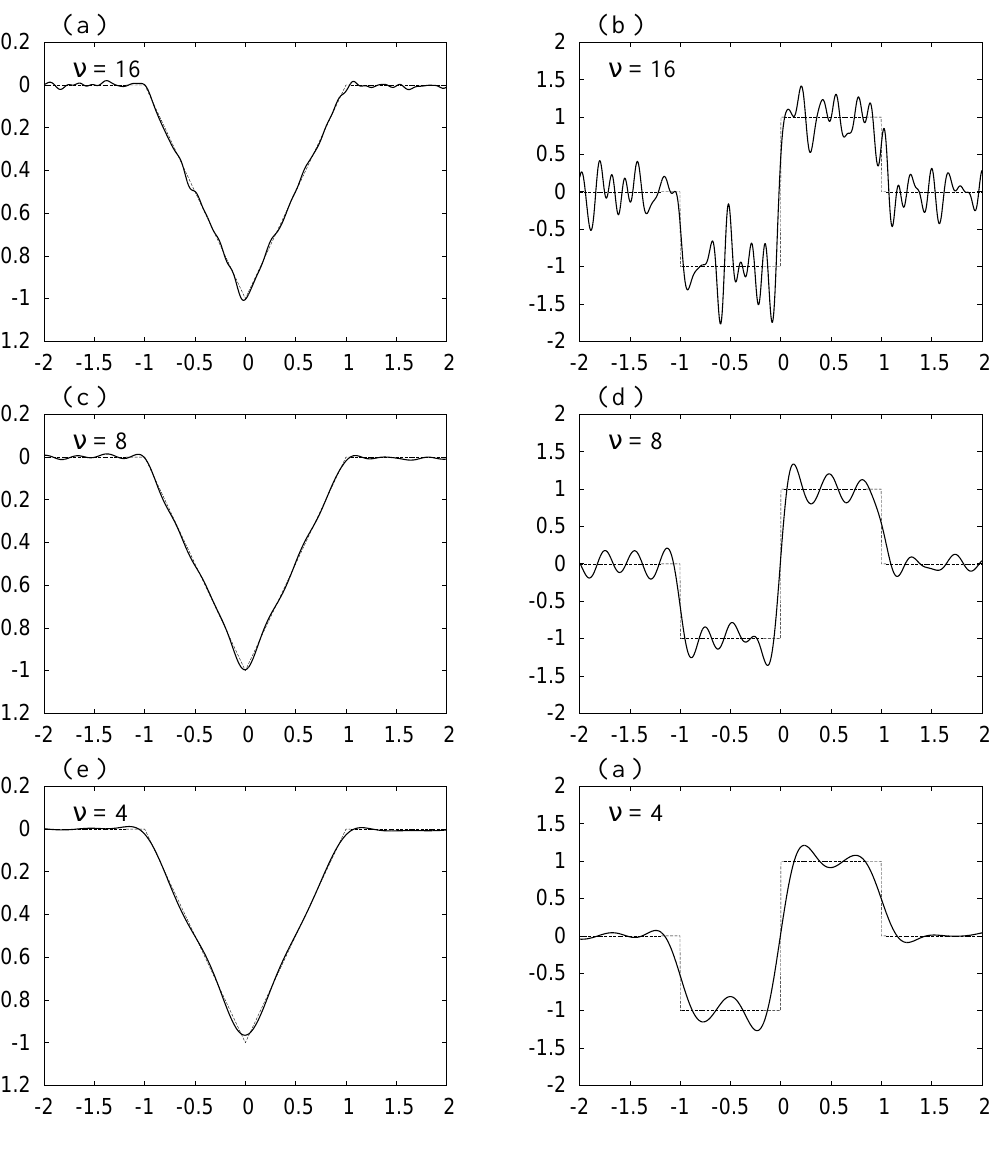
f ( x ) , M f ( x ) ; ( b ), ( d ), ( f ): ( M ν 1 ν 1 ,ϵ f ) ′ ( x ) ν 1